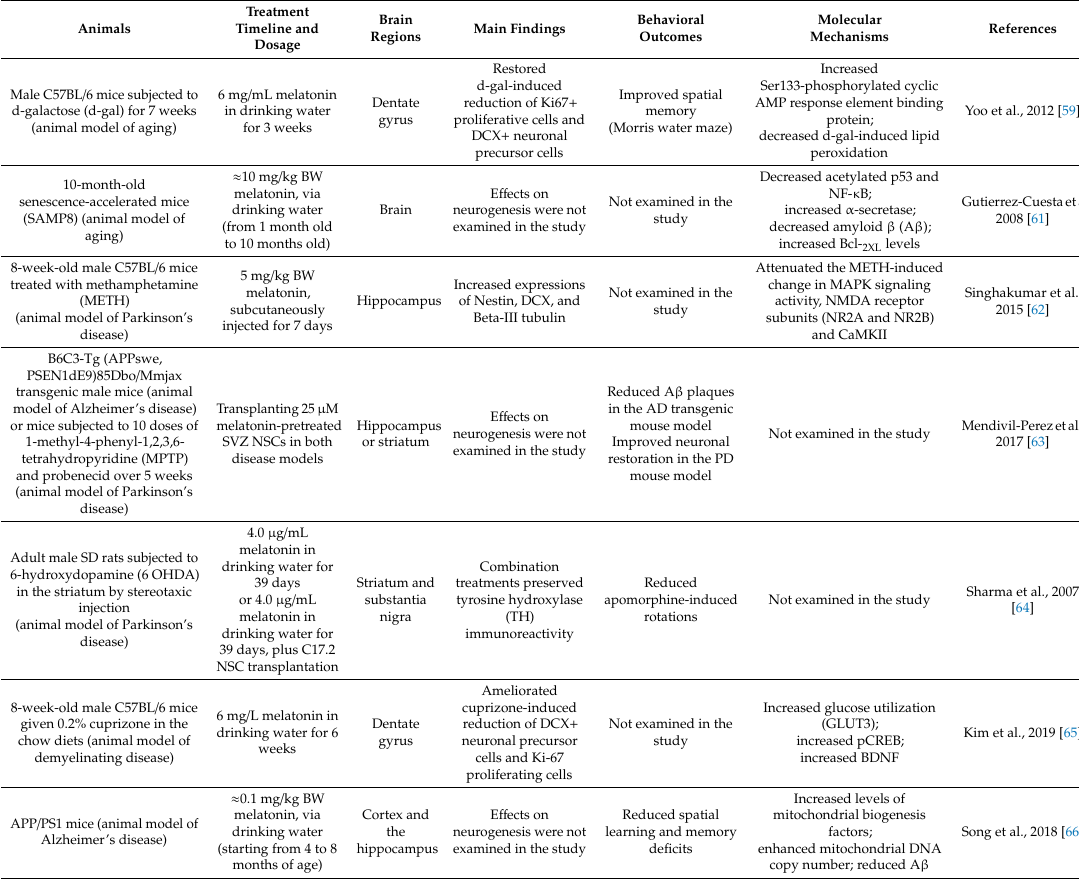
Table 4. Table showing the main findings regarding the e ff ects of melatonin on neurogenesis in aging and neurodegenerative diseases and the respective molecular mechanisms in the in vivo